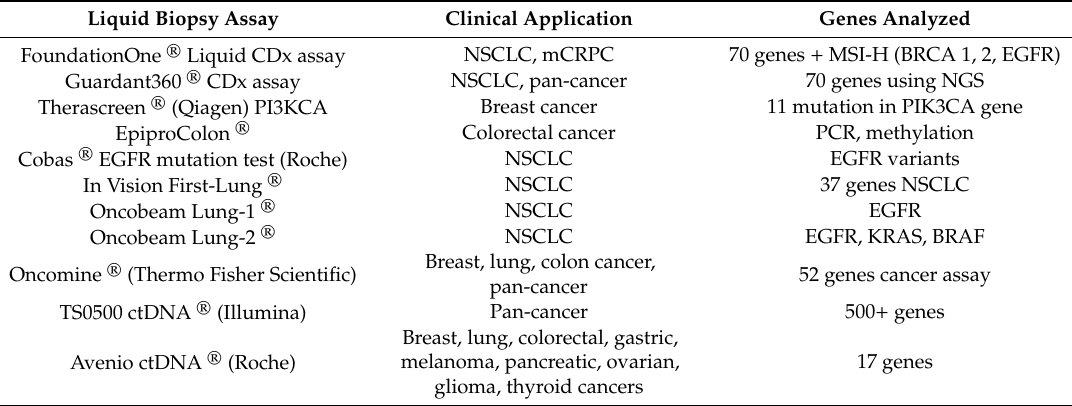
Table 1. Food and Drug Administration (FDA)-approved liquid biopsies